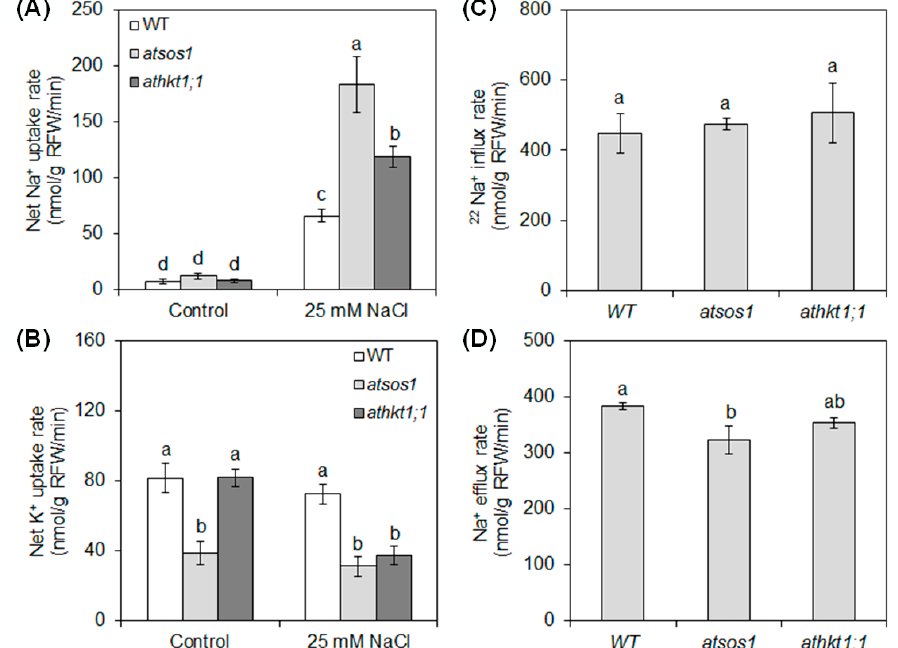
Figure 1. Net Na + ( A ) and K + ( B ) uptake rate in 6-week-old wild type (WT), atsos1 , and athkt1;1 with or without 25 mM NaCl for 4 d. 22 Na + influx rate ( C ) and Na + efflux rate ( D ) in 4-week-old WT, atsos1 , and athkt1;1 exposed to 25 mM NaCl. Values are means ± SE ( n = 8), and bars indicate SE. Columns with different letters indicate significant differences at p < 0.05 (Duncan’s test).